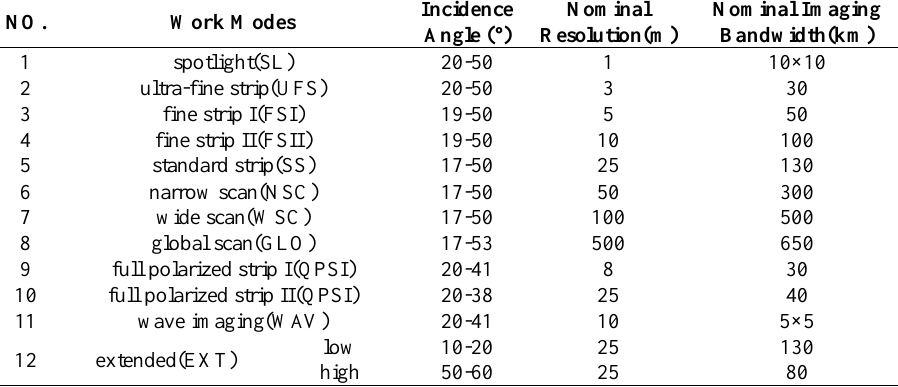
Table 1. The main technical specifications of each imaging